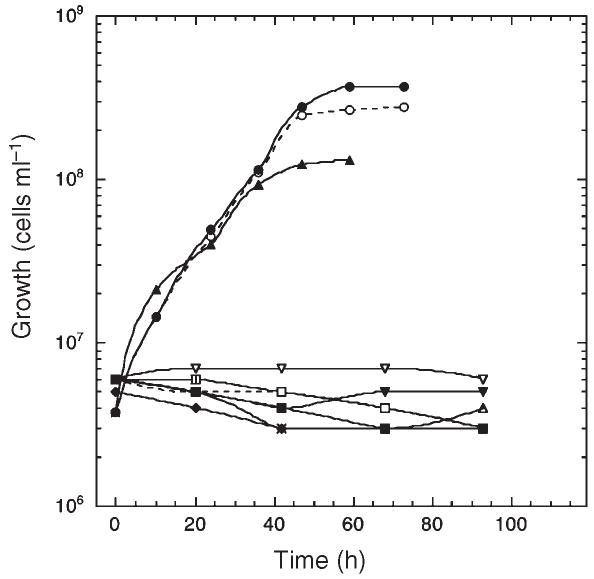
Figure 1. The S ° -dependent growth of S. marinus . Staphylothermus marinus was grown in 25 ml of modified 0.8× SME medium contain- ing ( (cid:2) ) no S ° , ( (cid:3) ) sublimed S ° (0.05%, w/v), ( (cid:4) ) colloidal S ° (0.05%, w/v), ( (cid:5) ) polysulfide (3 mM), ( (cid:6) ) Na 2 SO 4 (10 mM), (×) Na 2 SO 3 (10 mM), ( (cid:7) ) Na 2 S 2 O 3 (10 mM), ( (cid:8) ) cysteine (10 mM), ( (cid:9) ) cystine (10 mM), ( (cid:10) ) methionine (10 mM) or ( (cid:11) ) sand (3%, w/v) at 85 °C. Cell growth was monitored by direct cell counting.